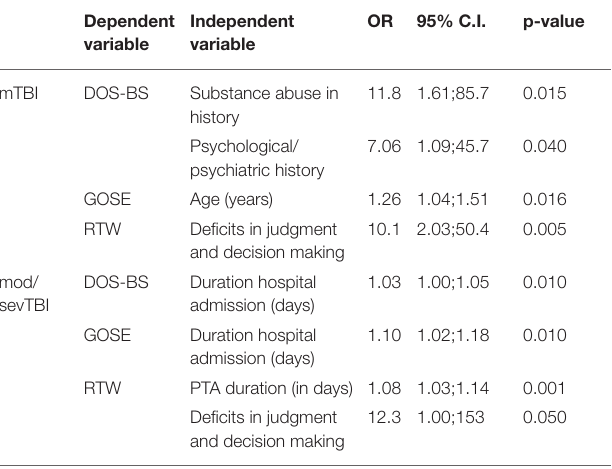
TABLE 4 | Multivariate logistic regression